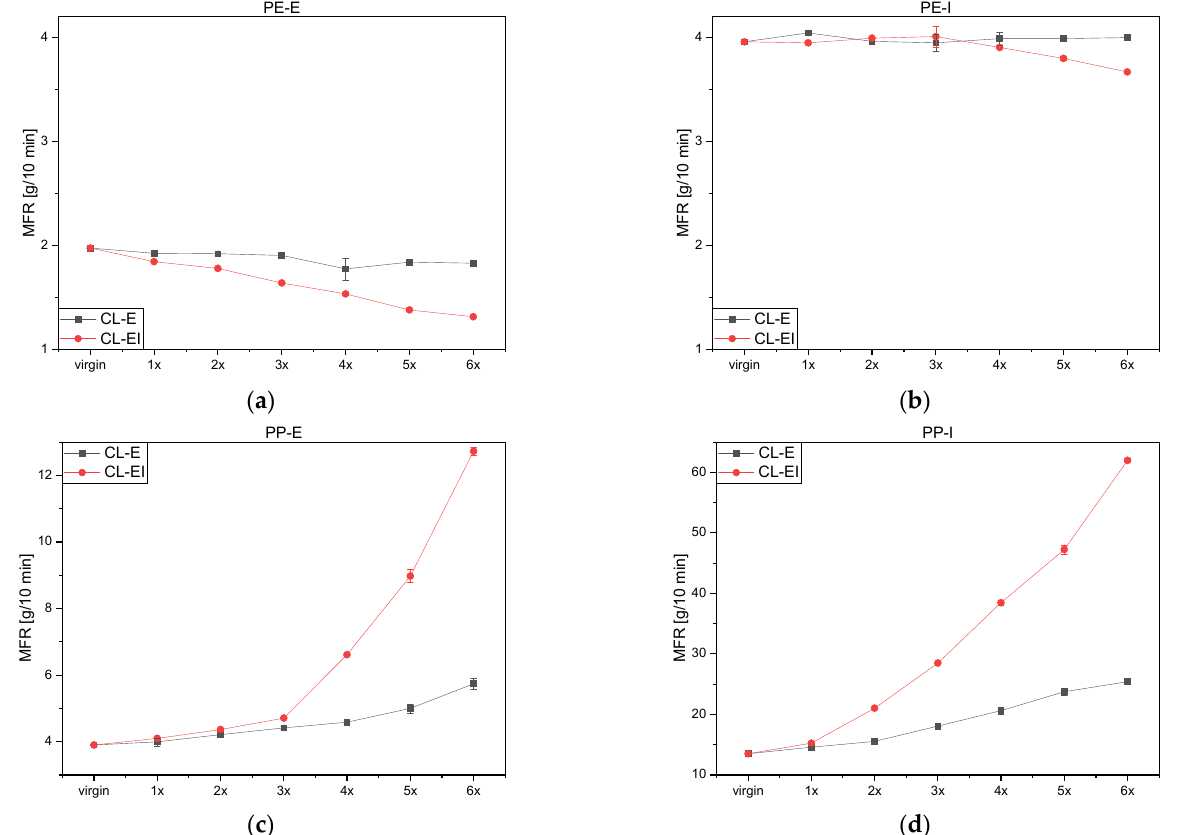
Figure 6. MFR values for both cycles ( a ) PE-E, ( b ) PE-I, ( c ) PP-E and ( d ) PP-I. Both PP grades showed a significant MFR increase after both loops (see Figure 6c,d).